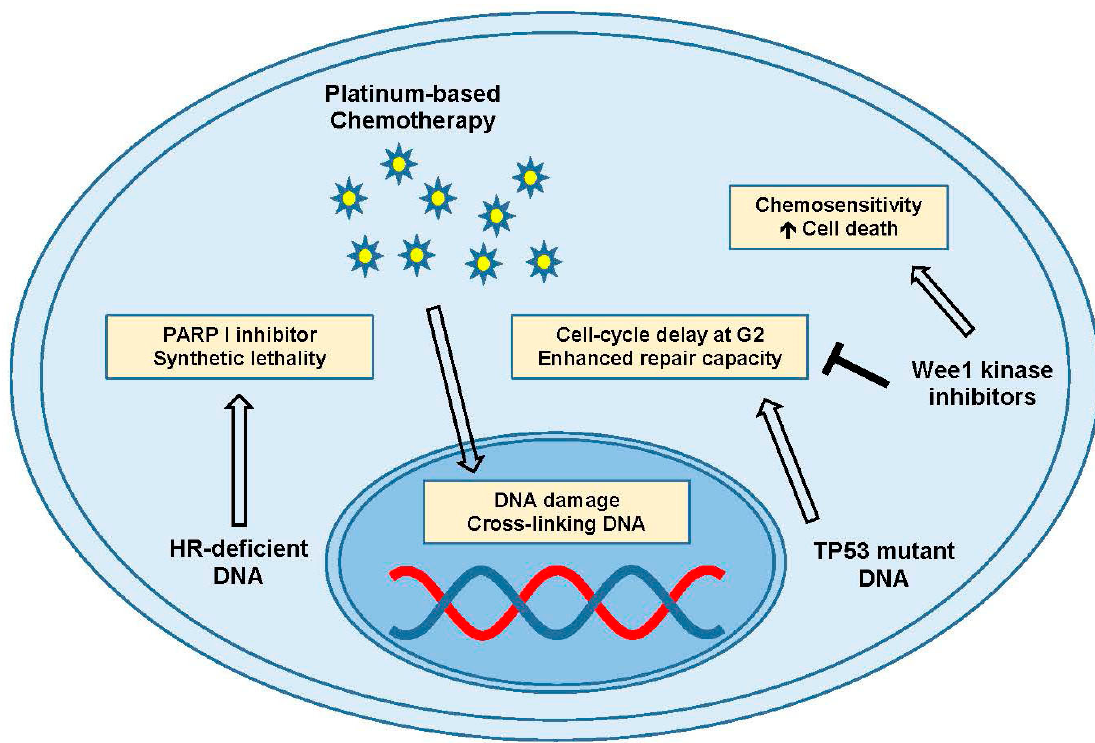
Figure 4. DNA damage and repair. PARP inhibitors in the presence of platinum-based chemotherapy and homologous recombination (HR) deficient DNA can induce synthetic lethality. TP53 mutated DNA can show cell cycle delay at the G2 phase, which can be inhibited by Wee1 kinase inhibitors to promote cell death and enhance chemosensitivity. Abbreviations: Gap 2 (G2); poly(ADP-ribose) polymerase-I (PARP I); tumor protein 53 (TP53).